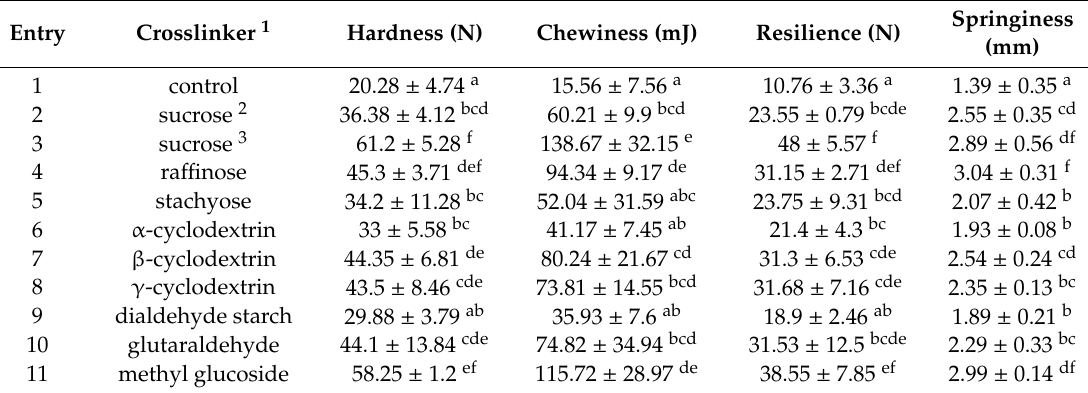
Table 2. Texture profile of HTT sea